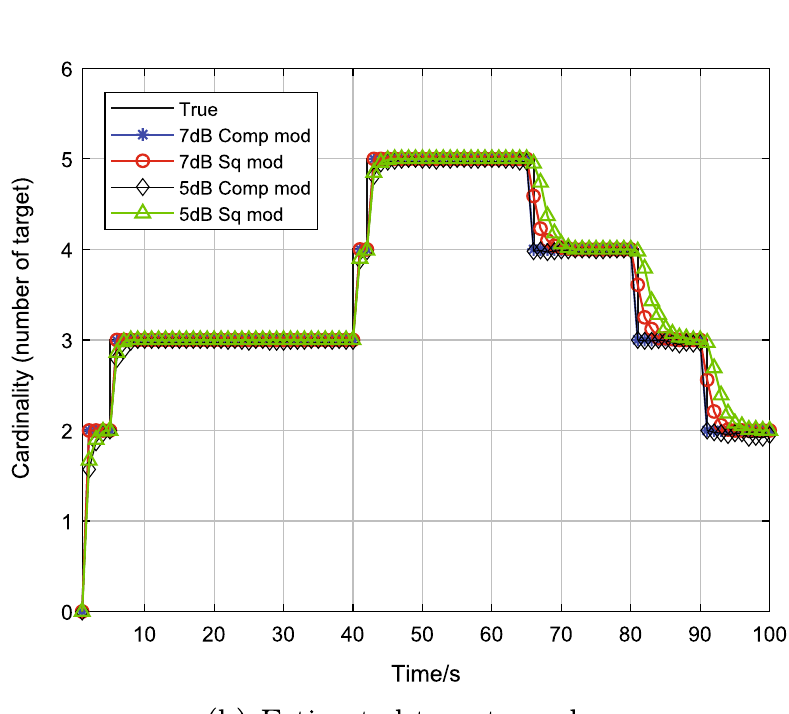
Fig. 10 Two likelihood ratio algorithms with different SNR ratios under Swerling